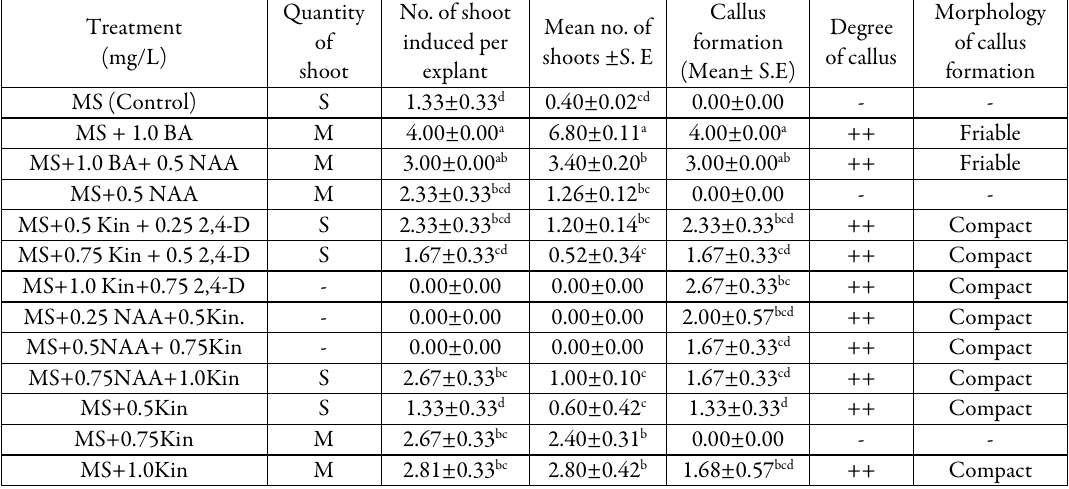
Table 2. Effect of different concentrations of auxins (NAA and 2, 4-D) and cytokinins (BA and kinetins) on shoot induction and callus formation from nodal explants of in vitro germinated P. erosus